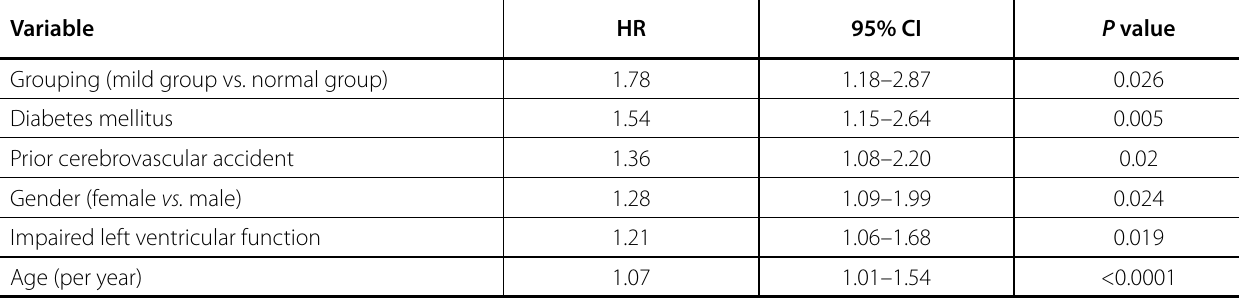
Table 5 . Predictors of long-term mortality. Variable